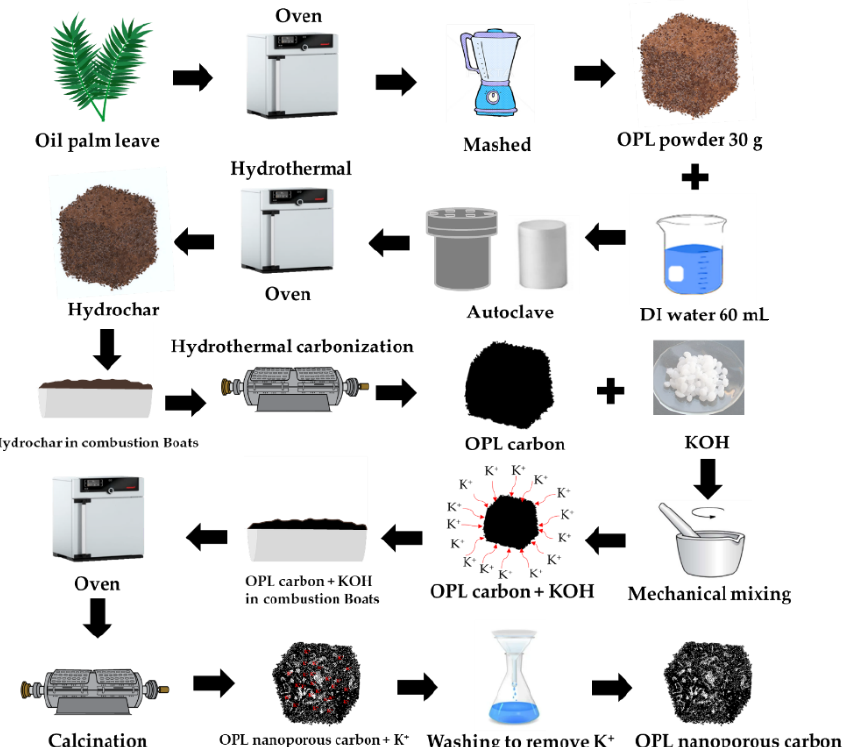
Figure 1. The step synthesis procedure of nano ‐ porous carbon materials derived from oil palm leaves via hydrothermal carbonization and KOH activation. via hydrothermal carbonization and KOH